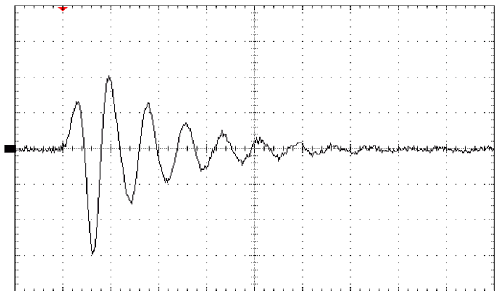
FIG. 30. Beam-induced resonant stripline BPM pickup signal voltage (vertical axis, 1 V = div) versus time (horizontal axis, 2 . 5 ns = div), sampled with a 20 GSample/s oscilloscope (screen- shot). Only the 500 MHz fundamental mode is visible, higher harmonics are suppressed with a low-pass filter.